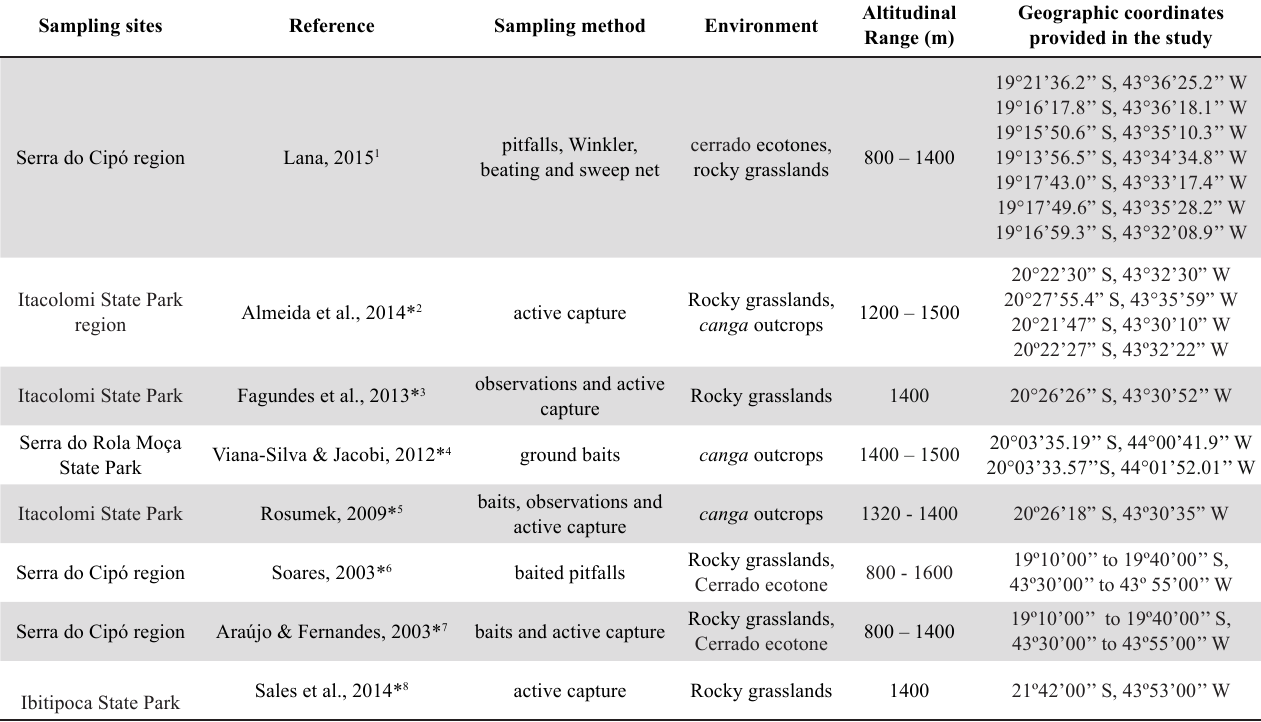
Table 1. Sites where ants were sampled in the Brazilian rocky